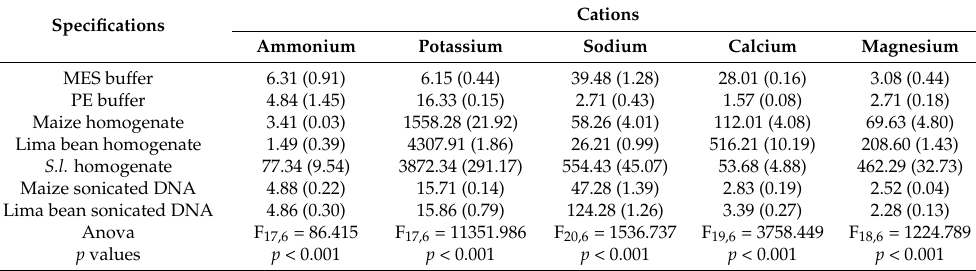
Table 1. Capillary electrophoresis analysis of different cations present in extraction buffers, leaf and Spodoptera littoralis ( S.l. ) homogenates, and fragmented DNA at 200 µ g · mL − 1 concentration. Values are expressed as mg · L − 1 (standard deviation). F subscripts are number of cases and degree of freedom,